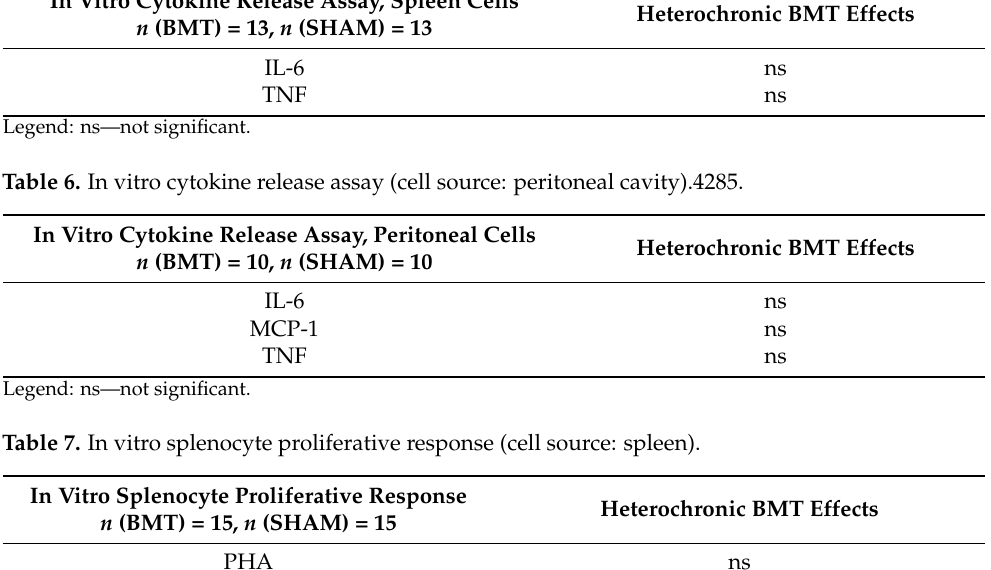
Table 5. In vitro cytokine release assay (cell source: spleen). In Vitro Cytokine Release Assay, Spleen Cells